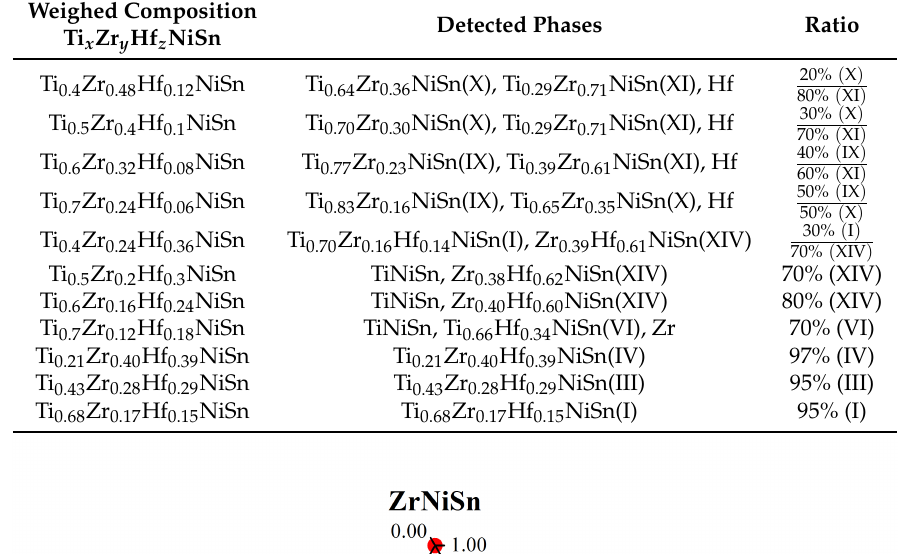
Table 9. The phase compositions of the different Ti x Zr y Hf z NiSn samples.